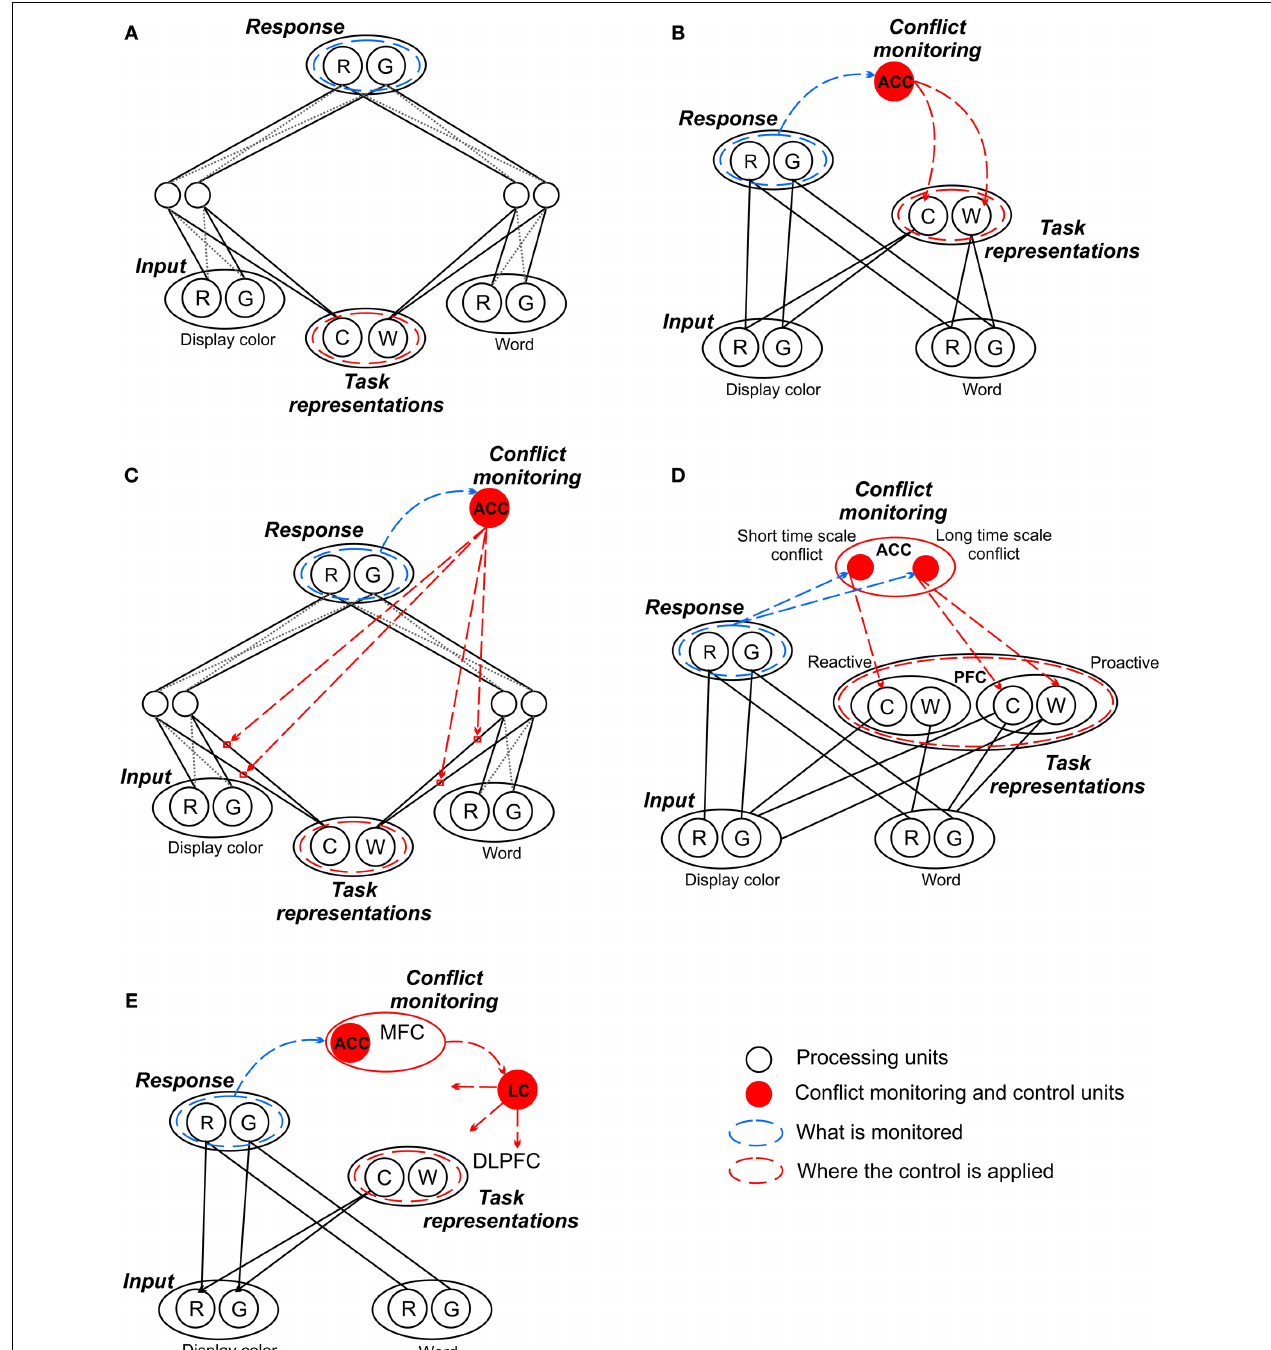
FIGURE 1 | The proposed architectures within the conflict-monitoring framework. (A) All models share the same core architecture introduced by Cohen et al. (1990) in their explanation of Stroop effect performance. This includes the definition of conflict as response competition , implying an aggregated contribution of task conflict and informational conflict. The assumption that conflict is controlled solely by adjustment of task representation weights implies that only the task conflict can be directly controlled. (B) Botvinick et al.’s (2001, 2004) model added a conflict-monitoring unit thereby generating a control loop for adjusting the task representation weights, while (C) Blais et al. (2007) proposed that task